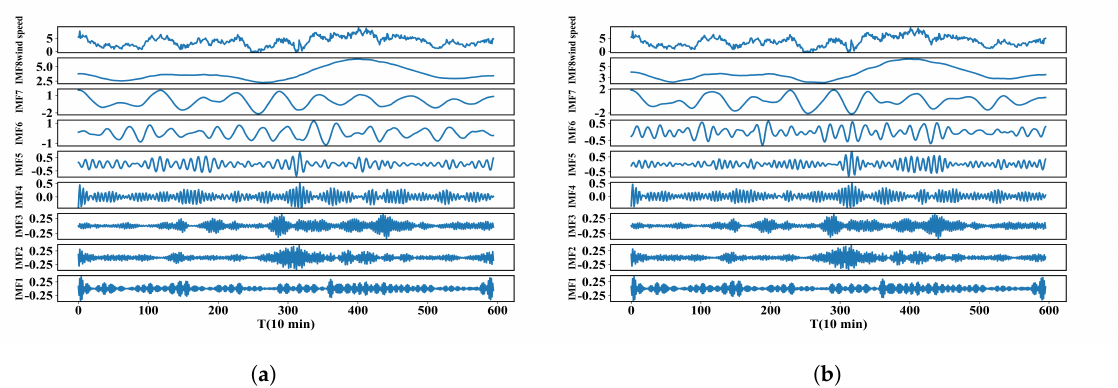
Figure 5. The decomposition results of different wind speed series by variational mode decomposition (VMD) algorithm: ( a ) wind speed series 1; ( b ) wind speed series